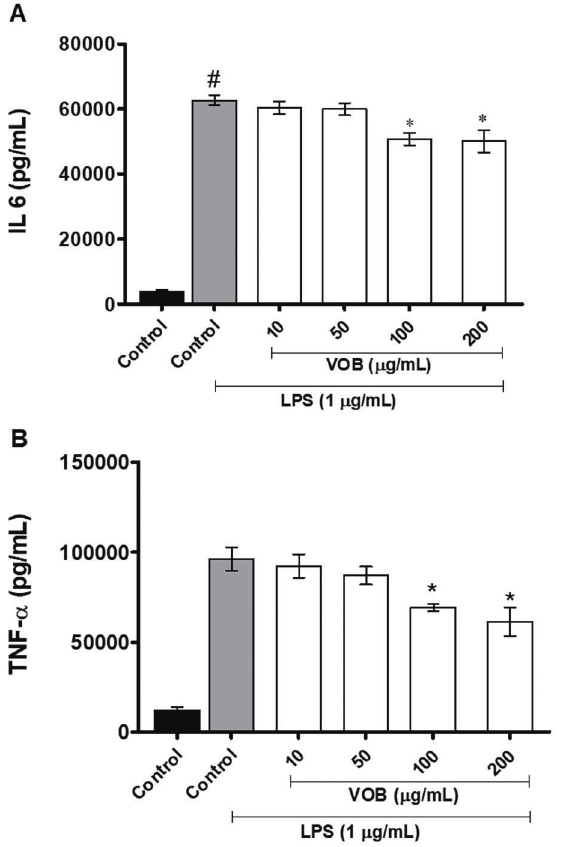
Figure 5. Effect of vegetable oil blend (VOB) on proin fl ammatory cytokine production in lipopolysaccharide (LPS)-stimulated macrophages. A , IL-6 and B , TNF- a production was measured using ELISA kits. Data are reported as means ± SE of two independent experiments. *P o 0.05 compared with LPS-treated cells. # P o 0.05 compared with control (ANOVA and the Tukey ’ s post-hoc test).